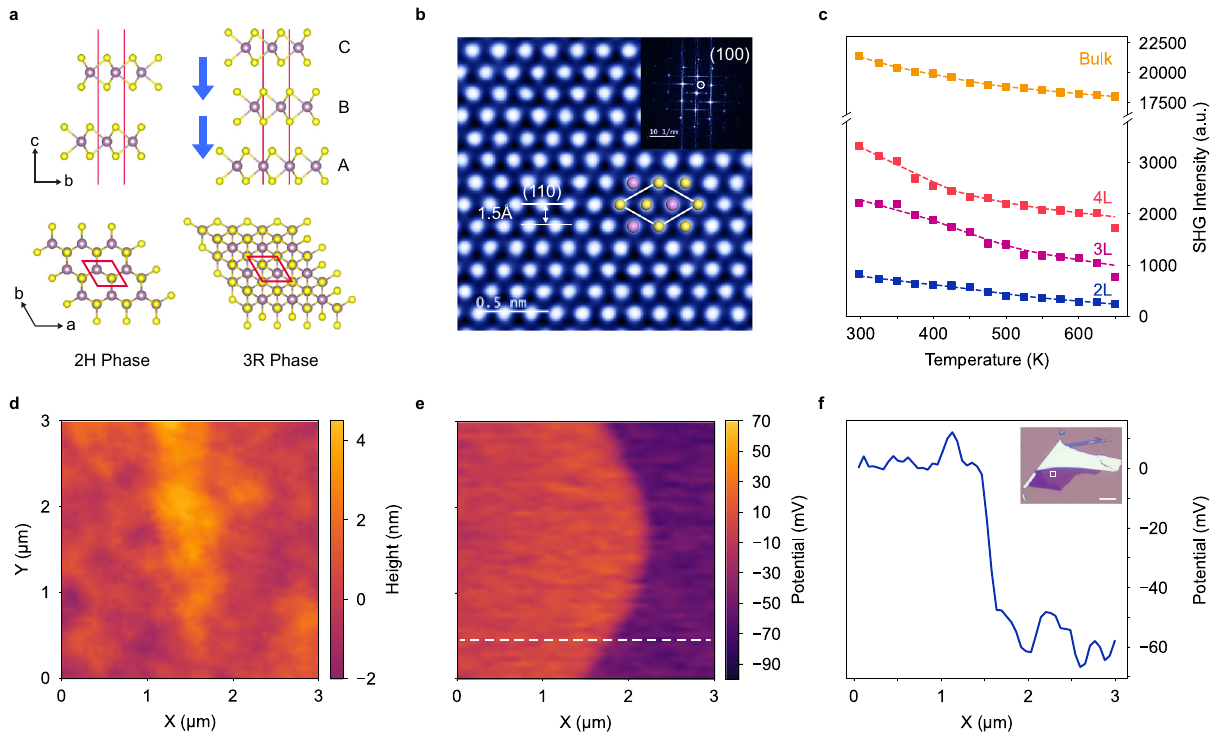
Fig.1|Veri fi cationofferroelectricityin3RMoS2.a Topandsideviewschematic of2Hand3RMoS2atomicstructures.Theyellowandpurplespheresrepresentthe sulfur and molybdenum atoms, respectively. The unit cells are marked by red diamond boxes. The blue arrows indicate the direction of spontaneous polariza- tion. b Atomic-resolution ADF-STEM image of thin 3R MoS2 fl ake. The unit cell is marked by the white diamond box, the yellow and purple spheres represent sulfur and molybdenum atoms, respectively. The d-spacing of the (110) plane is 1.5Å.